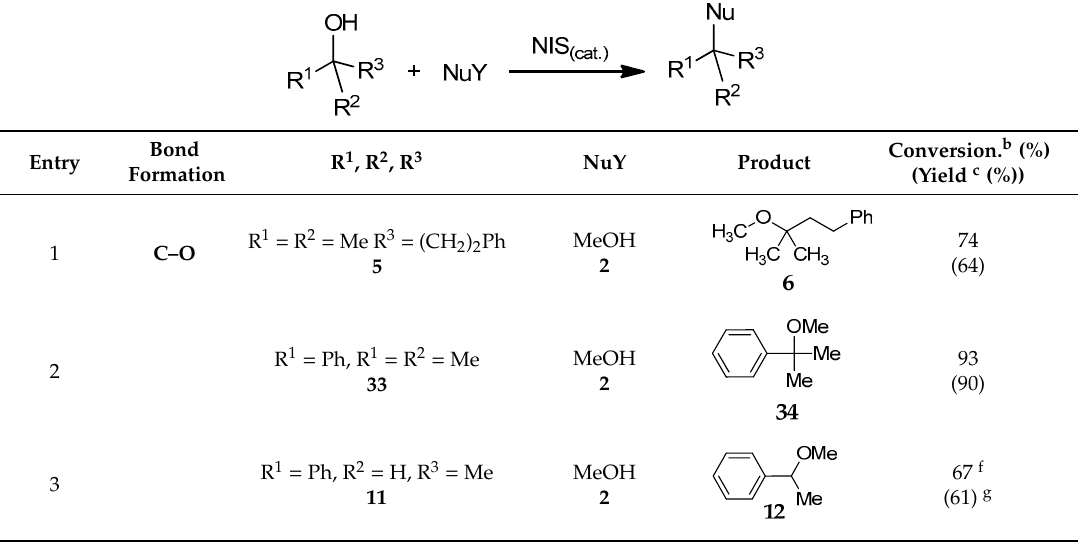
Table 4. Nucleophilic substitution of alcohols using NIS mediator a.